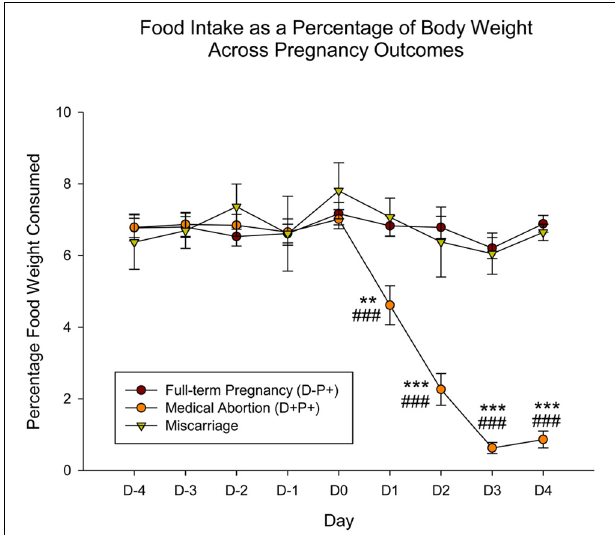
FIGURE 4 | Food intake as a percentage of body weight across gestation period across pregnancy outcomes. In contrast to the significant decrease in food intake displayed by rats in the D+P+ group, rats that naturally miscarried did not display any change in food intake. Pregnancy termination induced a significant reduction in food intake. n = 15 rats/group (D+P+ and D − P+); n = 4 rats (miscarriage group). ∗∗ p < 0.01, ∗∗∗ p < 0.001 (Relative to Miscarriage Group); ### p < 0.001 (Relative to D − P+). Data is expressed as mean ± SEM.